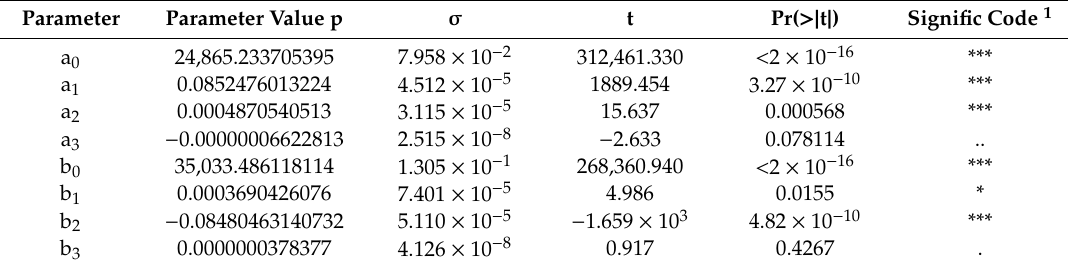
Table A2. Bilinear transformation parameter value p standard error σ , t value (t = P significance